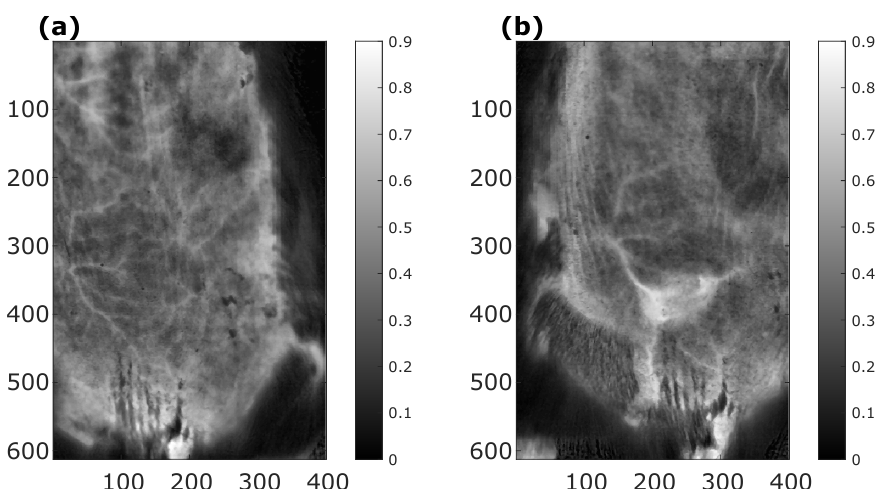
Figure 13. An example of utility of the custom-made laboratory hyperspectral imaging (HSI) system, with shown erythema index maps of a murine tumor model ( a ) before the tumor cells’ implantation and ( b ) six days after the implantation. Erythema index maps were calculated from recorded hyperspectral images. Since the erythema index is a ratio, it does not have units. Blood vessels are clearly visible as linear objects with higher intensity: comparison of the vessels before ( a ) and six days after the implantation ( b ) shows that vessels in the lower right corner became the tumor blood supply vessels (much brighter vessels indicating more blood), while the intensity of other vessels remained constant or even